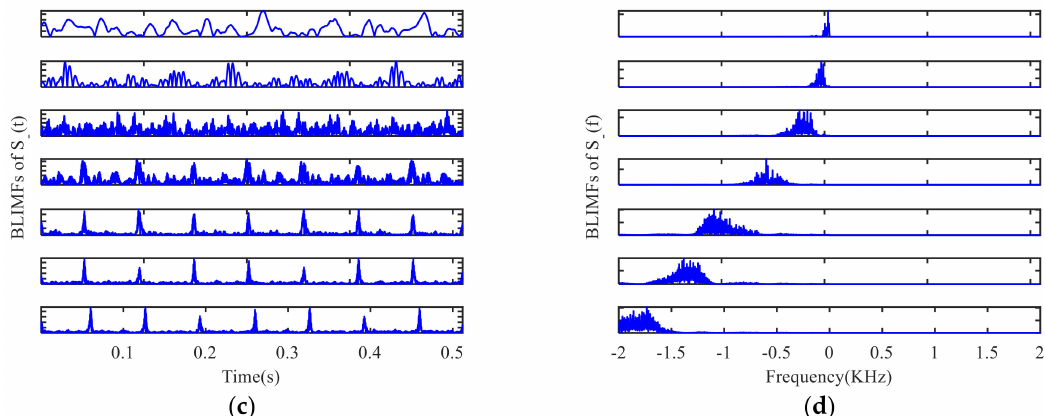
Figure 7. VMD of S + ( t ) and S − ( t ) : ( a ) BLIMFs of S + ( t ) in time domain, ( b ) BLIMFs of S + ( t ) in frequency domain, ( c )